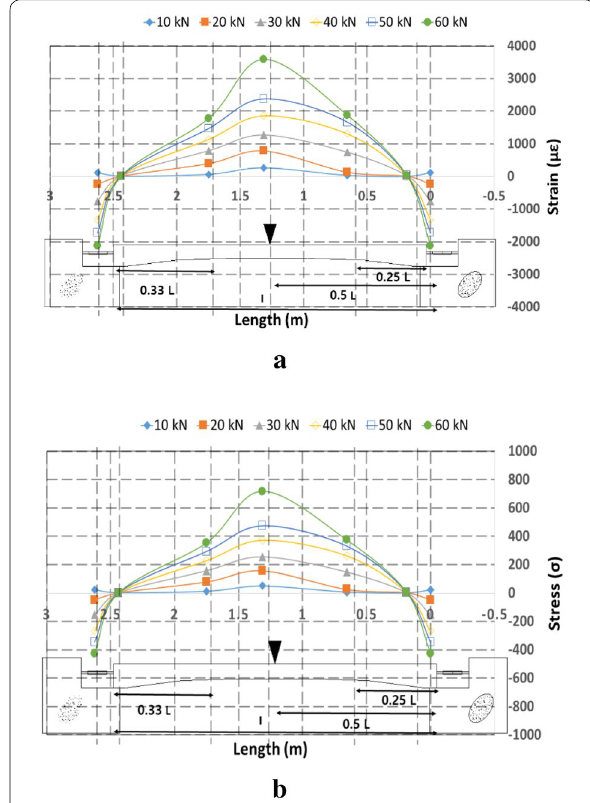
Fig. 9 AD length‑strain and stress relation curve. a AD length‑strain relation curve. b AD length‑stress relation curve.